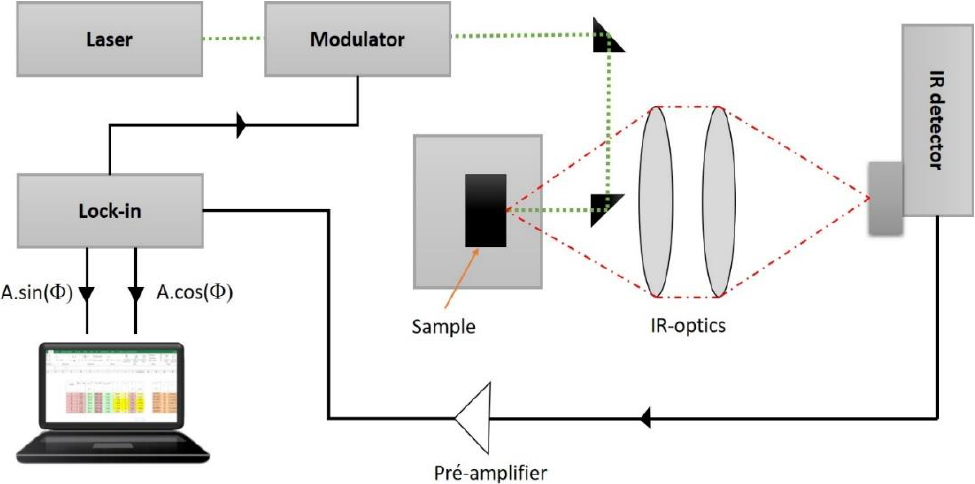
Figure 2. Schematic representation of the photothermal measurement device, comprising a laser (532 nm), an acoustic-optical modulator, Infra-Red (IR) optics and an IR detector, as well as a computer-controlled lock-in amplifier.